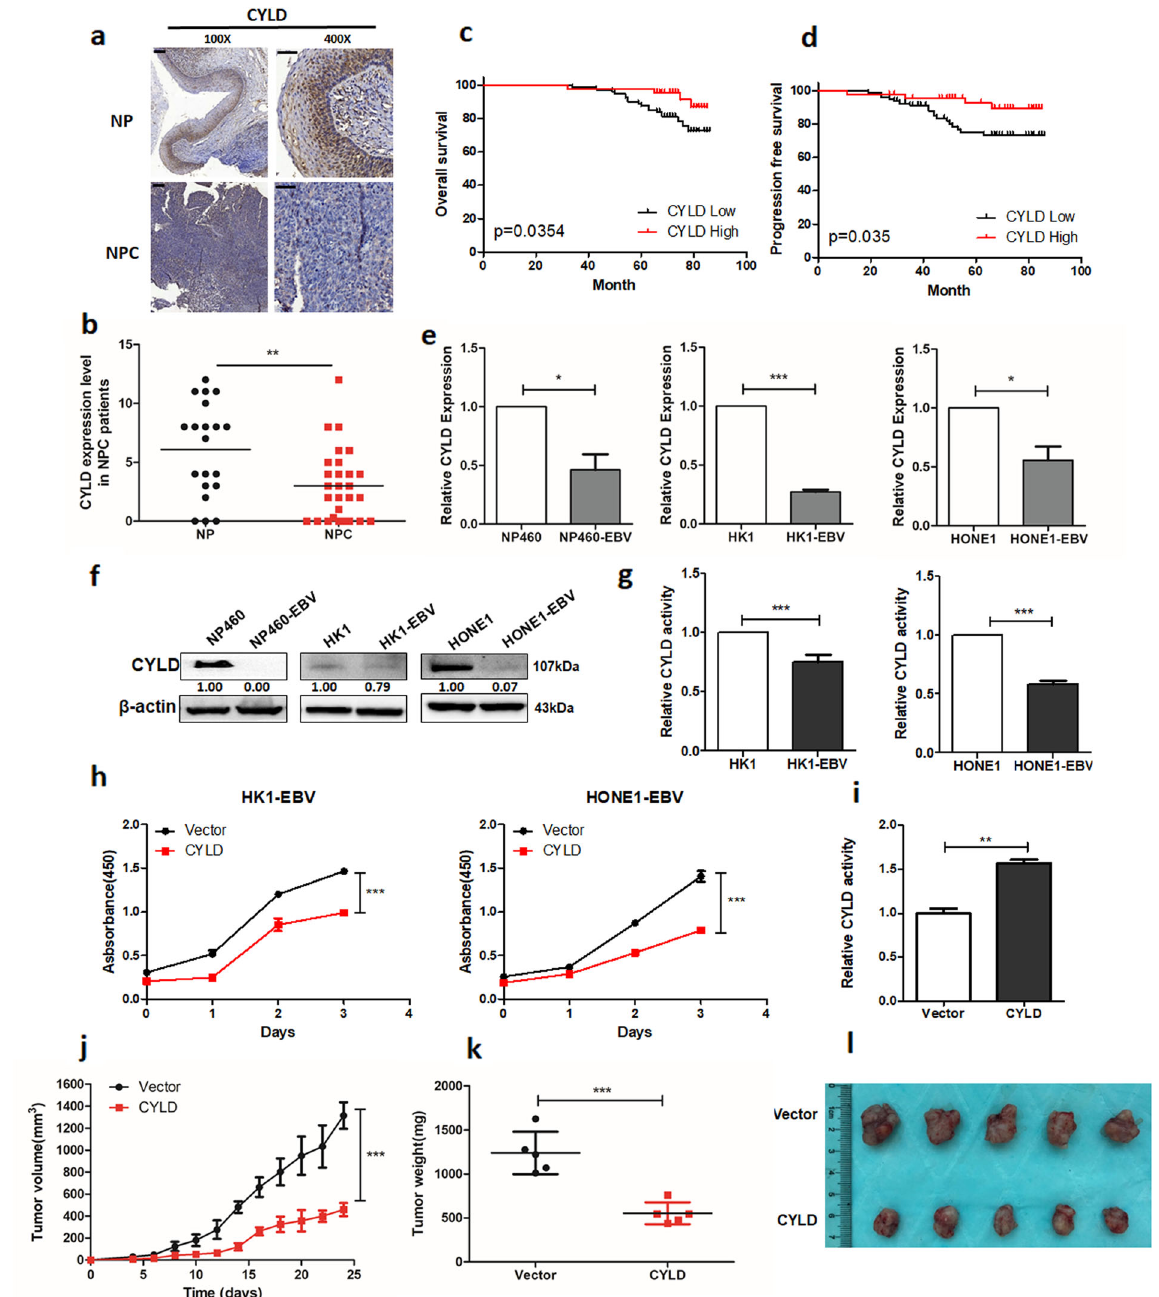
Fig. 1 EBV inhibits CYLD expression and contributes to tumorigenesis in NPC. a Representative IHC staining of CYLD expression from pathological sections of NPC patients (100×: scale bar, 100 μ m; 400×: scale bar, 50 μ m). b Histoscores of CYLD expression in NPC patients ( n = 29) compared to nasopharyngeal (NP) tissue ( n = 20). c Overall survival and d Progression free survival rates of NPC patients with low ( n = 71) or high ( n = 58) expression levels of CYLD were estimated by the Kaplan – Meier method using log-rank test. Group according to CYLD median expression. e mRNA and f protein expression of CYLD in NP460/NP460-EBV, HK1/HK1-EBV, and HONE1/HONE1-EBV cell lines. g DUB activity measurement of CYLD in HK1/HK1-EBV, HONE1/HONE1-EBV cells. h HK1-EBV and HONE1-EBV cells were infected with a lentivirus and proliferation was monitored using CCK8 assays at the indicated time points. Statistical signi fi cance was determined by a two-tailed, unpaired Student ’ s t test. The indicated cells (5 × 10 6 ) were subcutaneously injected into mice. i CYLD activity in tumor extracts. j Tumor growth, k tumor weight, and l tumor images are shown. (Data are represented as mean ± SEM ( n = 3). Differences were considered signi fi cant at * p < 0.05, ** p < 0.001, *** p < on p18 is cleaved by CYLD, we used 293T cells transfected with ubiquitylated p18 and incubated these two proteins in a cell- Myc-p18, Flag-CYLD, together with HA-tagged ubiquitin mutants free system. As expected, CYLD decreased p18 polyubiquityla- (K6, K11, K27, K29, K33, K48, or K63). Overexpression of CYLD tion in vitro (Fig. 4e).These data indicate that CYLD directly signi fi cantly decreased K48-linked poly-Ub, but not any other deubiquitylates p18. To investigate which type of poly-Ub chain